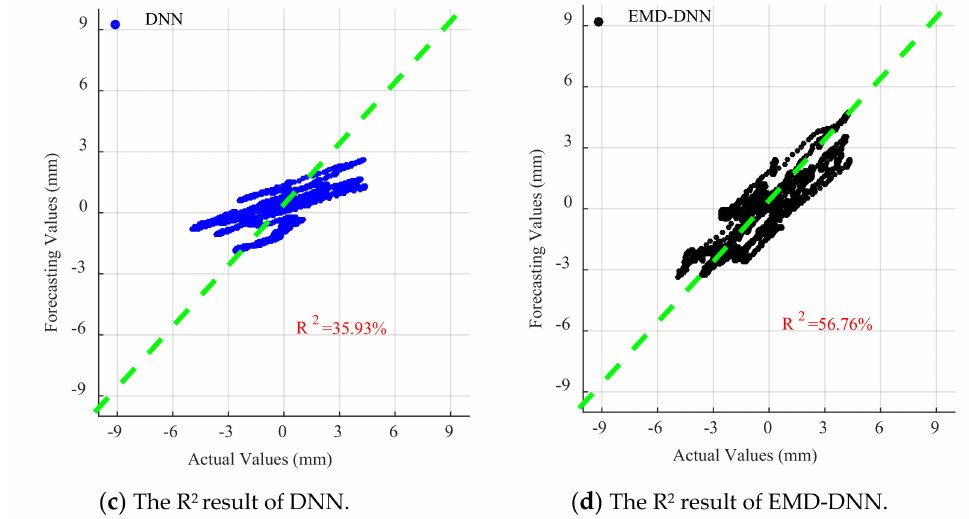
Figure 16. Scatter diagram of different correction methods for EL centro wave.